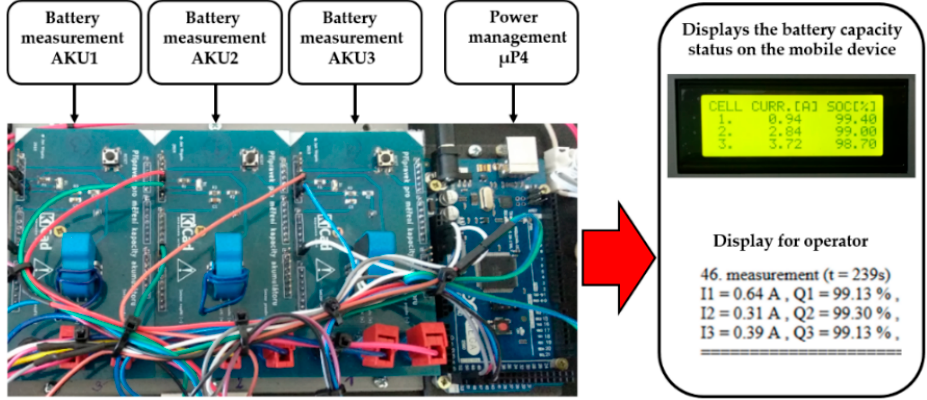
Figure 3. Displaying the power source of the individual accumulators.